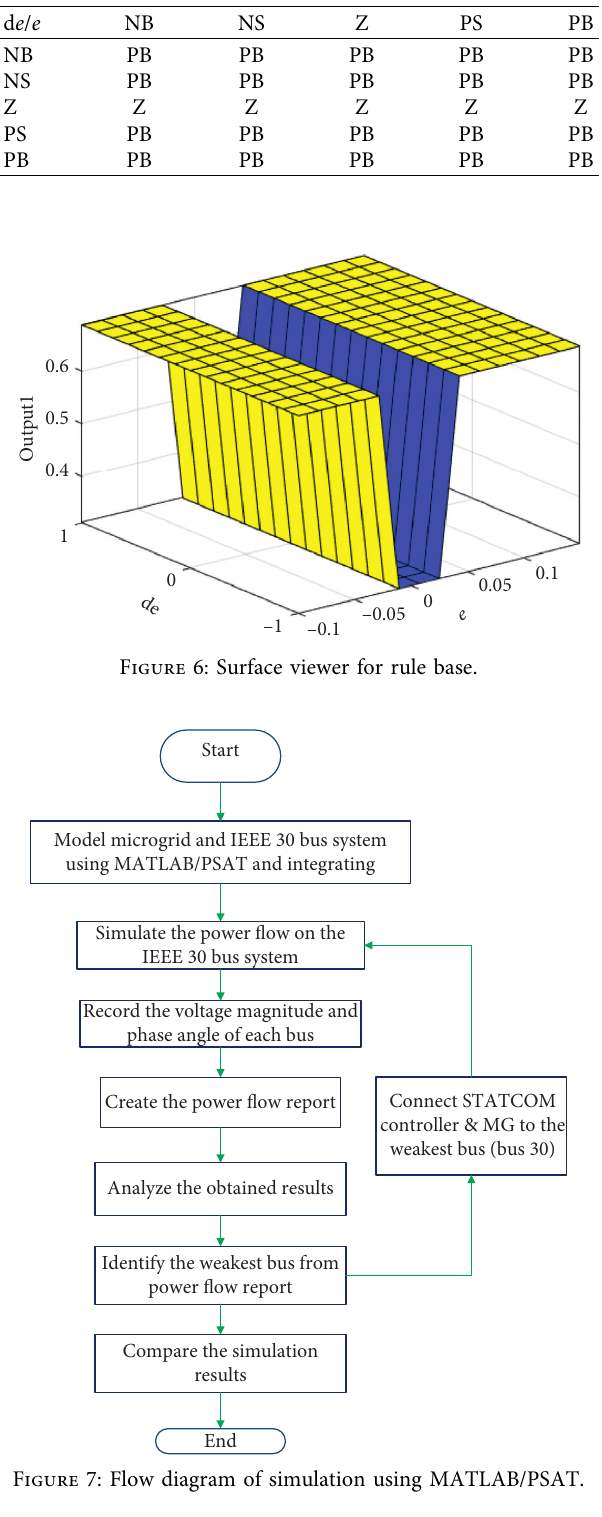
Table 1: Rule base for fuzzy-PI controller.